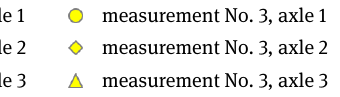
Figure 3: Dependence of braking forces on control pressure for